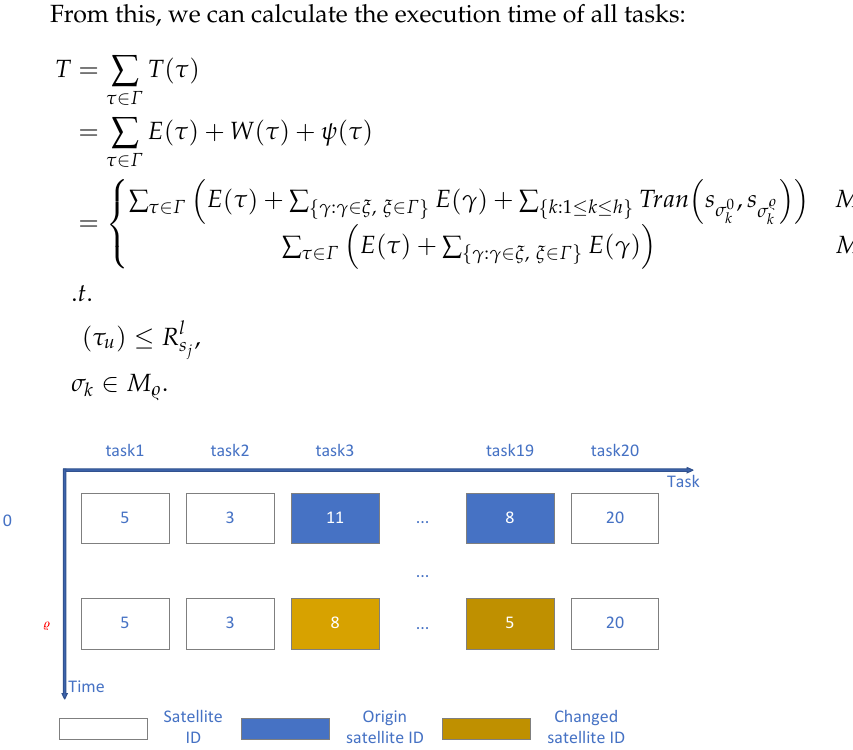
Figure 7. The matrix representation of the tasks on the satellite, the horizontal axis represents the tasks that increase in order, the vertical axis represents the time, and the value in the element is the satellite